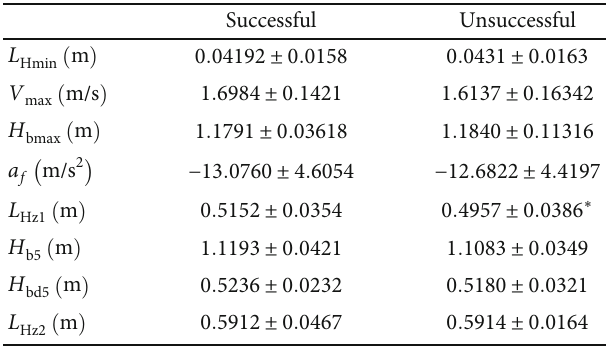
Table 2: Comparative analysis of the parameters of “ Near, ” “ Fast, ” and “ Low ”